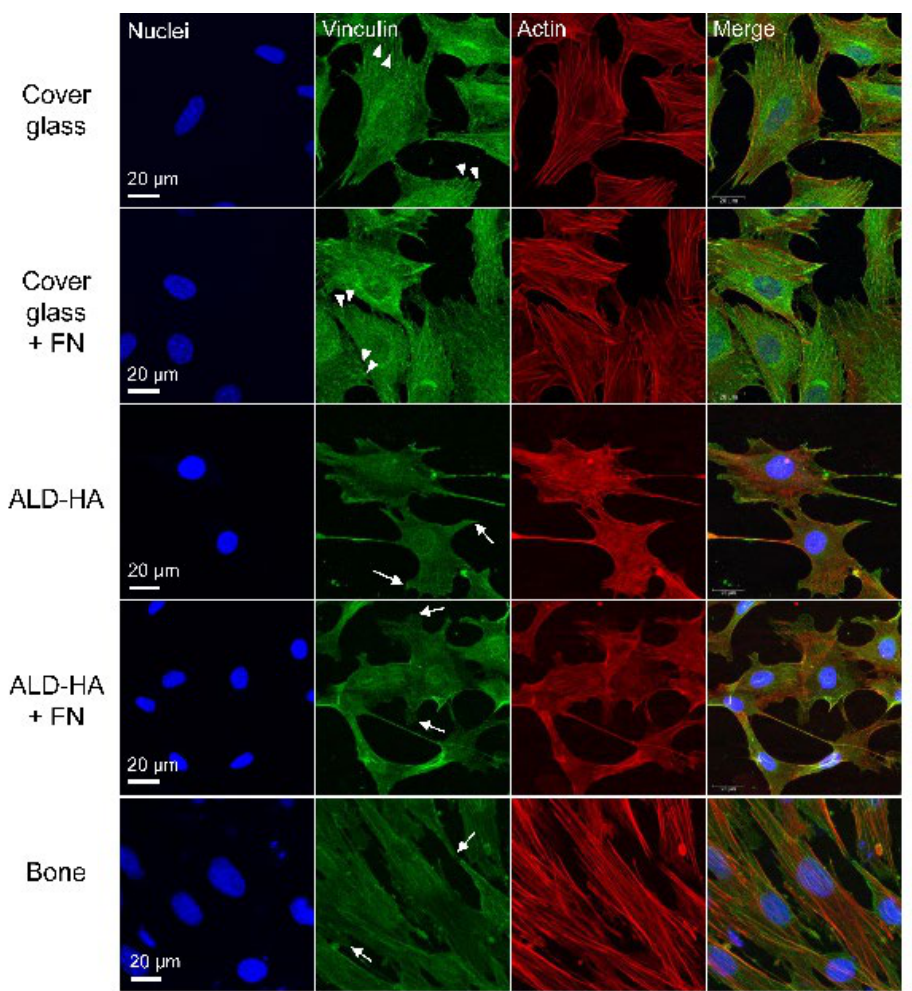
Figure 2. Focal adhesion localization in MC3T3 cells. Focal adhesion staining of MC3T3 cells on cover glass, ALD-HA and bone slice after 48h culture (representative data from one culture). Nuclei were stained with Hoechst 33258 (blue), focal adhesions with anti-vinculin (green) and actin cytoskeleton with TRITC-phalloidin (red). Images were taken with fluorescence microscope and 63× objective with 1.48 zoom, and maximum intensity projections were created from Z-stacks. Cover glasses and ALD-HA samples were either non-coated or coated with fibronectin (FN). Focal adhesion-like structures were present at the edges of the cells on all surfaces, although on ALD-HA and bone these structures were thinner (arrows) compared to thicker dot-like structures observed on cover glass (arrowheads). Fibronectin coating did not have an effect on the cell morphology or vinculin staining.